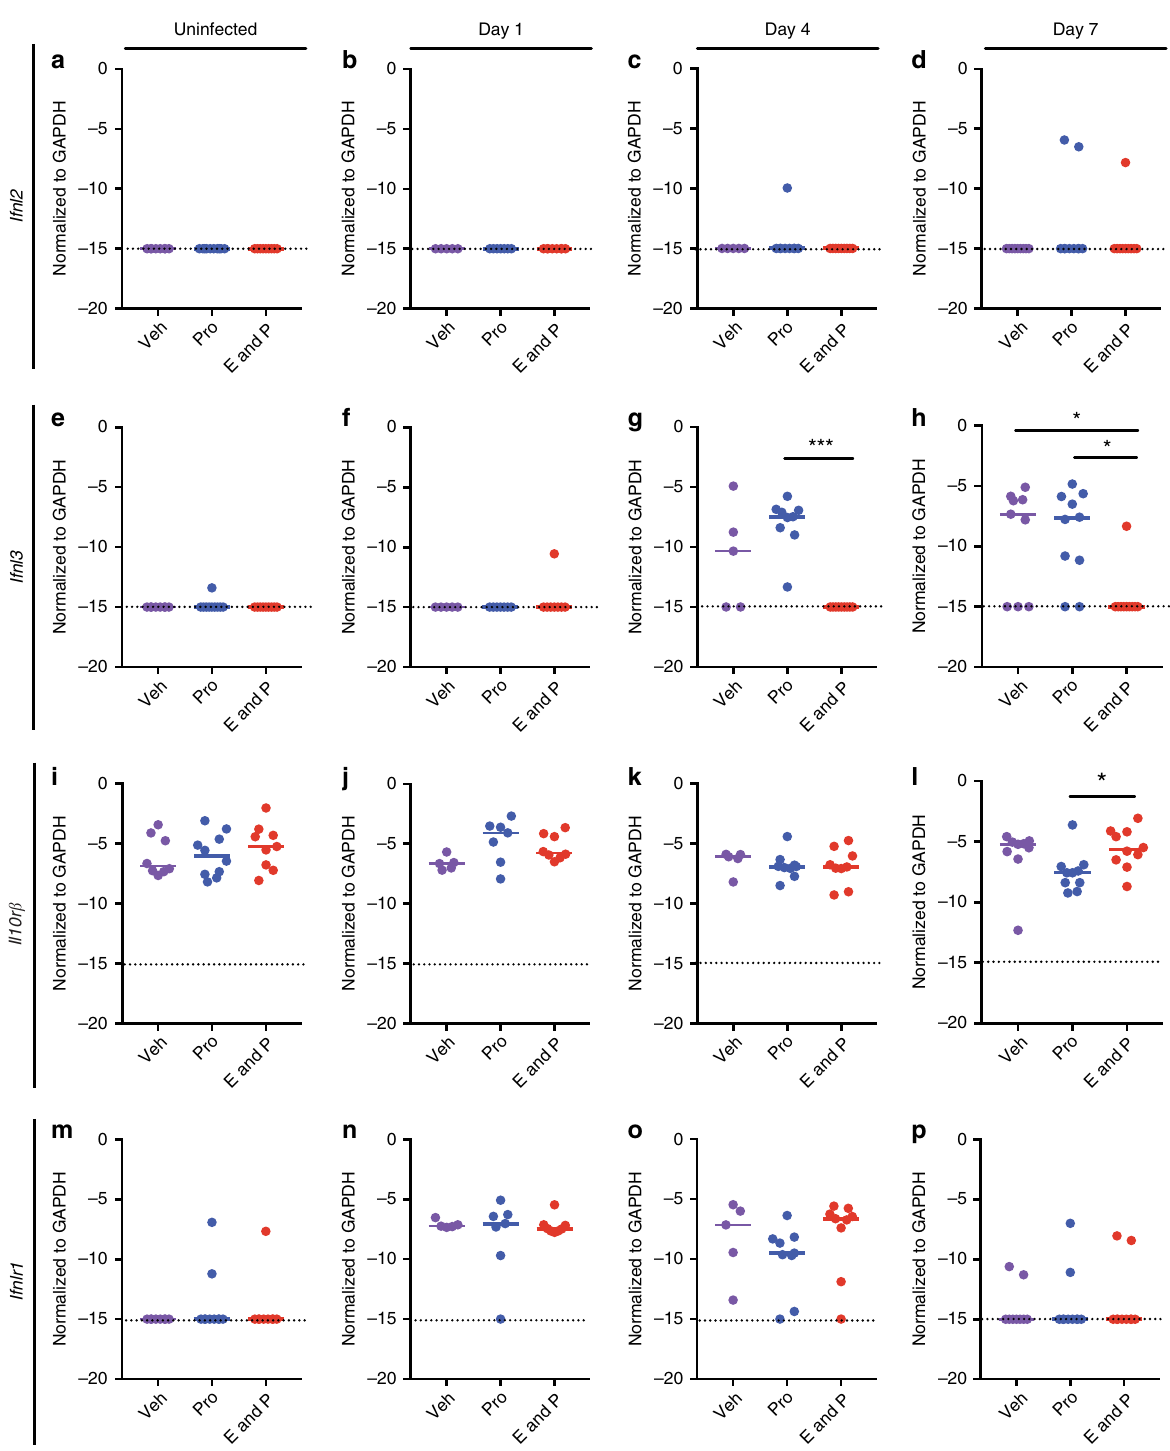
Fig. 5 IFN- λ and its receptor expression are hormone-dependent after intravaginal ZIKV infection. Six-week-old WT OVX mice were given hormone replacement regimens of vehicle, progesterone-only, or a combination of estradiol and progesterone. Mice were treated with 1 mg of anti-Ifnar1 mAb at day − 1. On day 0, mice were inoculated via intravaginal route with 10 6 FFU of ZIKV (Dakar 41525); 1, 4, or 7 days after infection, total RNA was extracted, and mRNA expression analyzed by RT-qPCR ( Ifnl2 a – d ; Ifnl3 e – h ; Il10r β i – l ; Ifnlr1 m – p ). Uninfected animals (for comparison) were harvested at the day 7 time point. Dotted lines indicate the LOD. Results are pooled from two or three experiments. Bars indicate median values (Kruskal – Wallis test: *, P < 0.05, ***, P < 0.001). Numbers of mice: Uninfected vehicle n = 8; Uninfected progesterone n = 10; uninfected estradiol and progesterone n = 9; day 1, vehicle n = 5; day 1, progesterone n = 7; day 1, estradiol and progesterone n = 8; day 4, vehicle n = 5; day 4, progesterone n = 9; day 4, estradiol and progesterone n = 9; day 7, vehicle n = 9; day 7, progesterone n = 10; and day 7, estradiol and progesterone n =